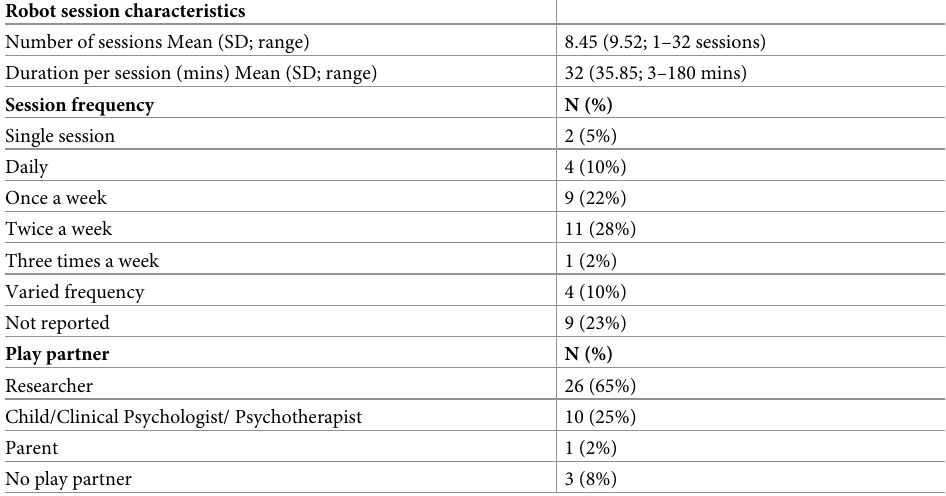
Table 2. Summary of features of robot-mediated